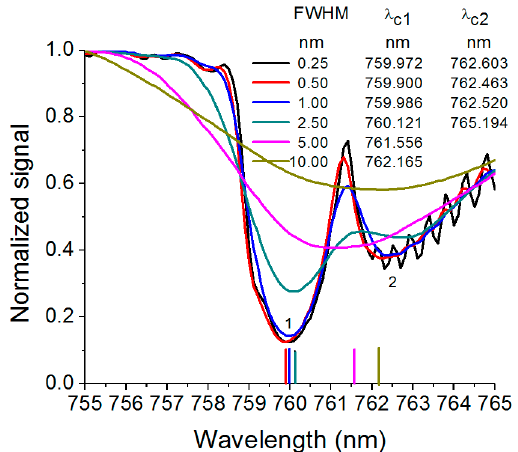
Figure 1. The sunlight signal intensity measured in the spectral range 755–765 nm with the spectral calibration system, an OL-750D double monochromator from Gooch & Housego (Orlando, FL, USA), using different slit widths. The vertical lines represent the positions of the centre wavelengths associated with specific configurations of the double monochromator. The same colour coding was used for wavelength positions corresponding to the FWHM values. Original radiometrically-calibrated data provided by Chris MacLellan, NERC Field Spectroscopy Facility, University of Edinburgh, U.K.